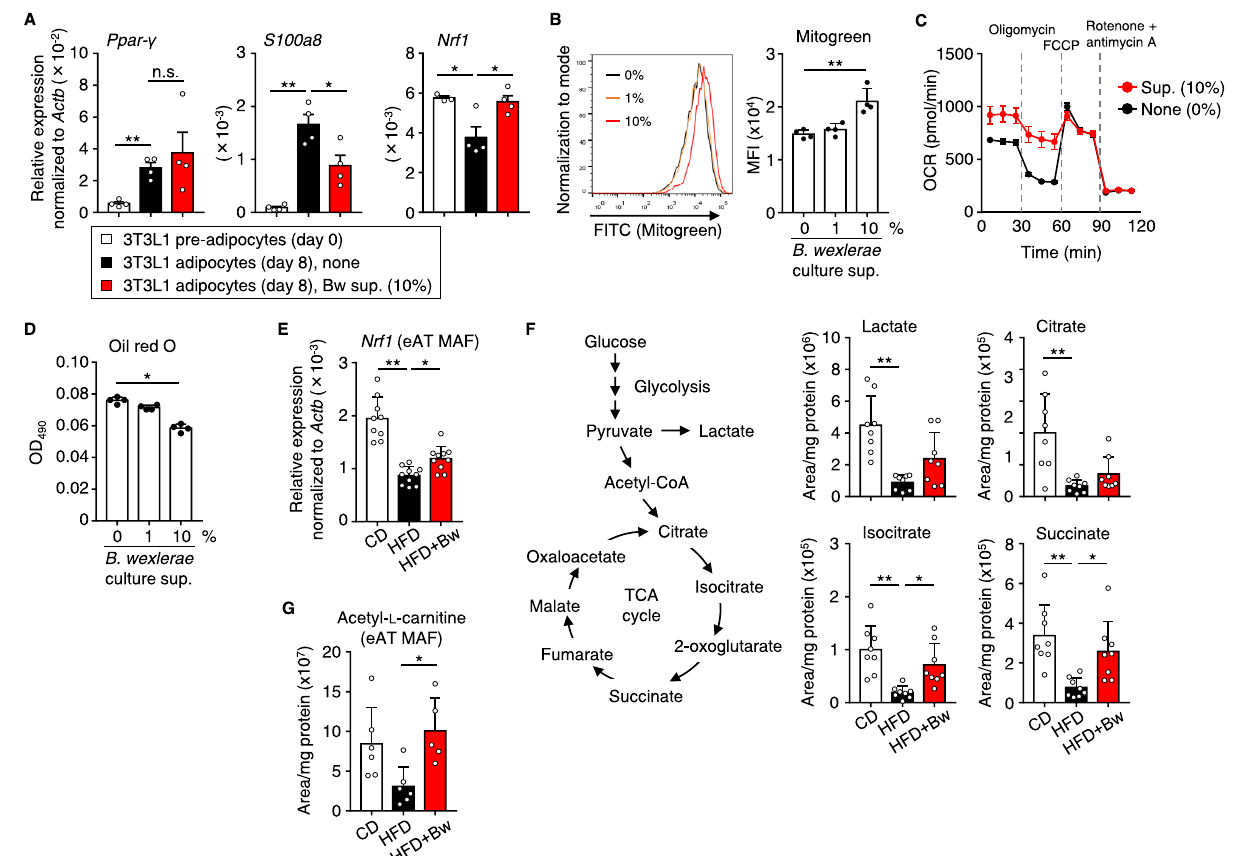
anti-adipogenesis properties in adipocytes as well as alteration of mitochon- drial metabolism. A 3T3L1 pre-adipocytes were differentiated into mature adi- pocytes in the absence (none) or presence of the cultured supernatant of B. wexlerae at a fi nal concentration of 10%. Gene expression of Ppar γ (a transcription factor used as a marker of adipocyte differentiation), S100a8 (a chemokine for recruiting macrophages), and Nrf1 (a transcriptional factor used as a marker of mitochondrial biogenesis) was measured in 3T3L1 pre-adipocytes and adipocytes. Data are representative of two independent experiments without samples